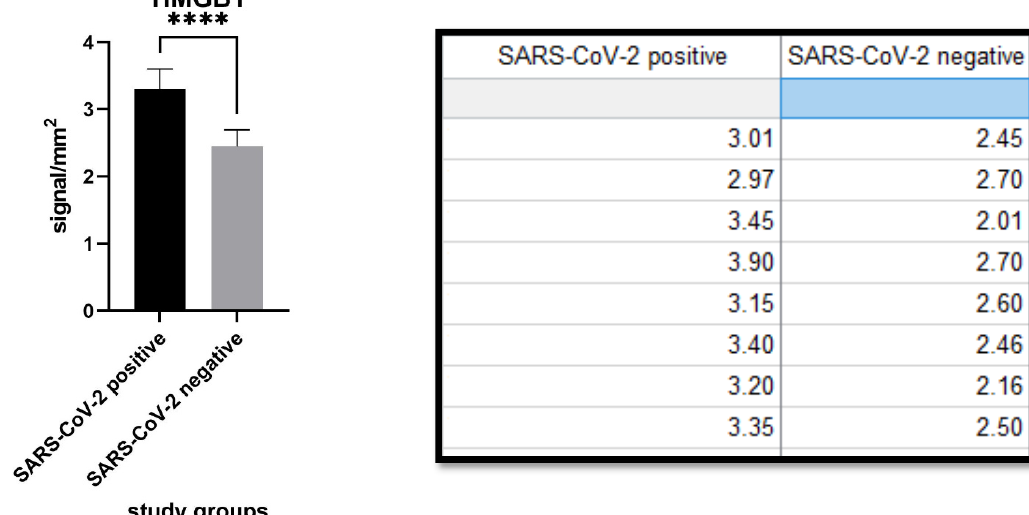
Figure 5. Different levels of HMGB1 immuno-expression in the two study populations. Note that there was statistically significant difference ( p value < 0.0001, <0.05). The signal was calculated in a semi-quantitative way as reported in the paragraph “Material and Methods”. **** statistic significative. TIM-3 expression was 2.453 ± 0.4616 (cells/mm 2 ) in the SARS-CoV-2 positive patients group and 1.199 ± 0.2461 (cells/mm 2 ) in the SARS-CoV-2 negative patients group. The difference was statistically significant ( p value < 0.0001). (Figures 6 and